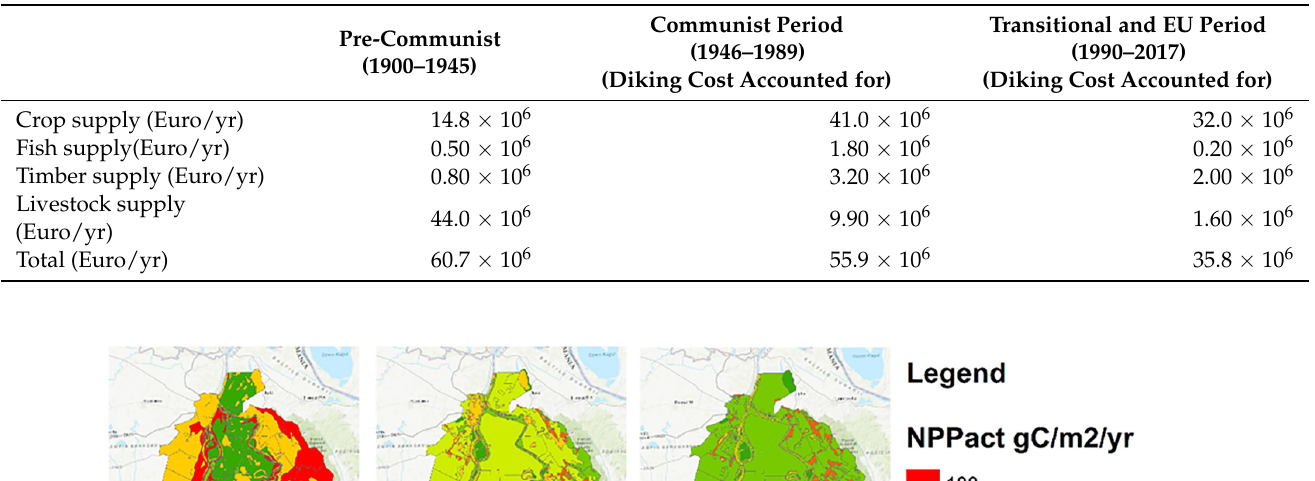
Table 3. Economic values of the selected four provisional ES in the case study area, including investment costs, for the three periods of environmental history.